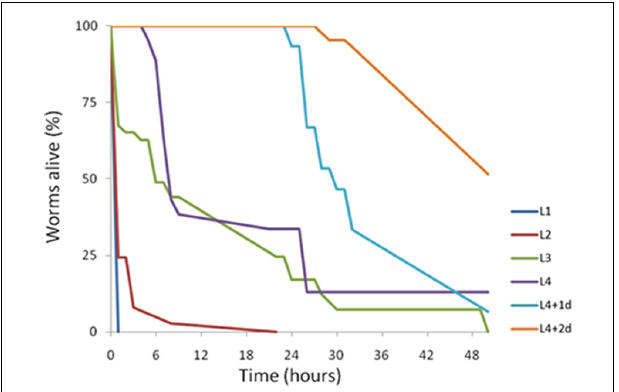
FIGURE 2 | Caenorhabditis elegans shows age-dependent sensitivity to theA153 nematicide. Survival of different larval stages and adult C. elegans worms when cultured on S. plymuthica A153.The results of a representative trial with at least 50 worms under each condition is